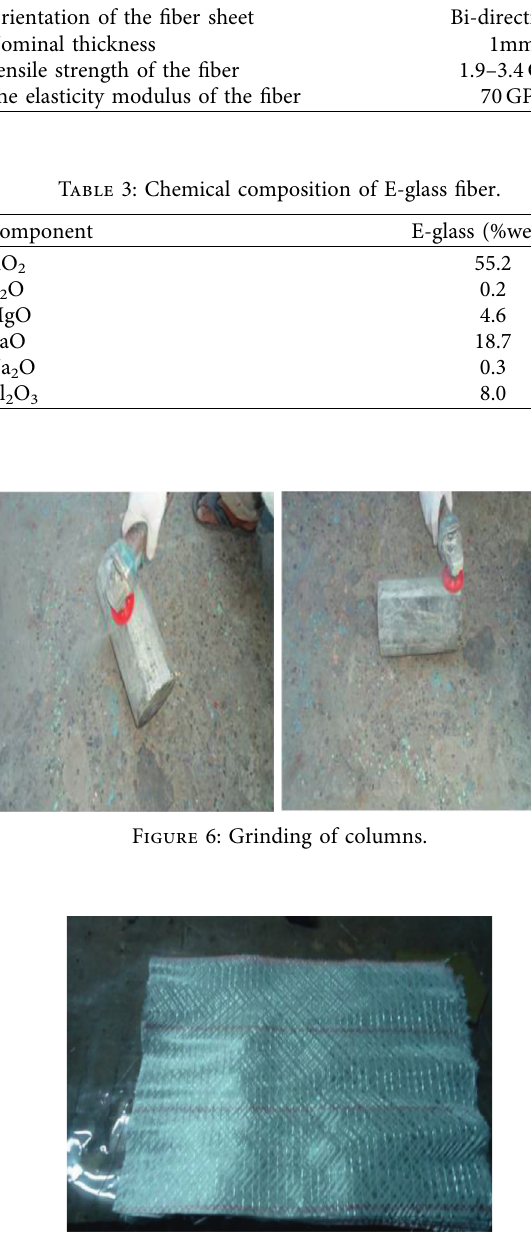
Figure 7: Selection of GFRP